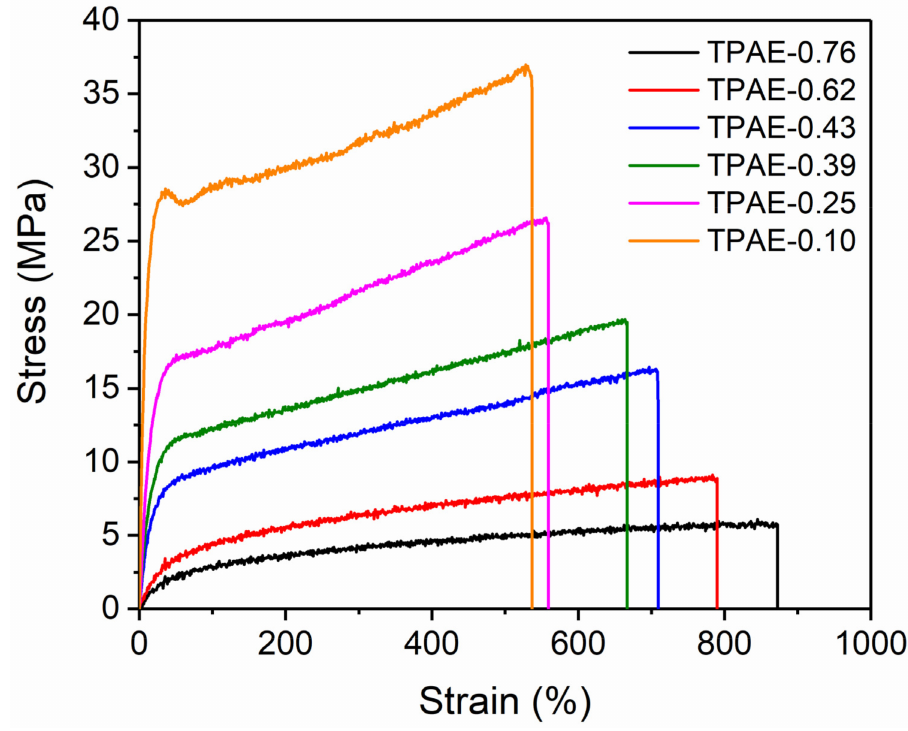
Figure 10. Tensile stress–strain curves of TPAE